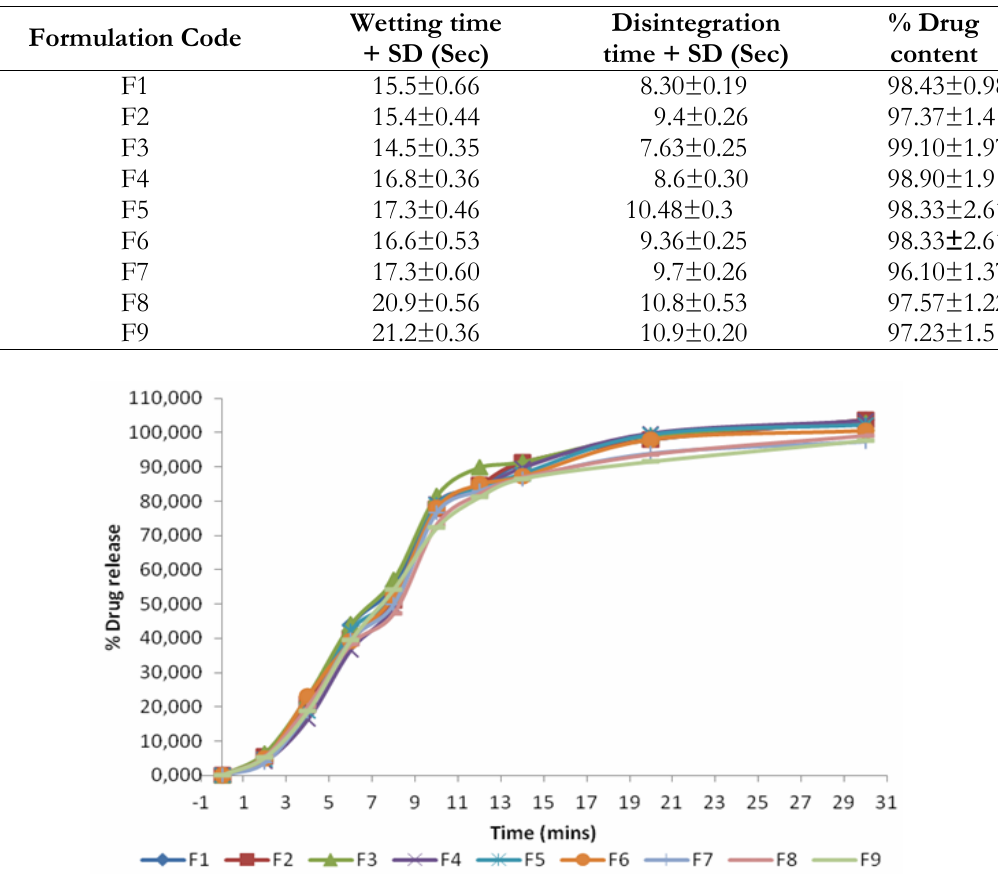
Figure 3. Invitro dissolution profile of FDTs of Pimozide